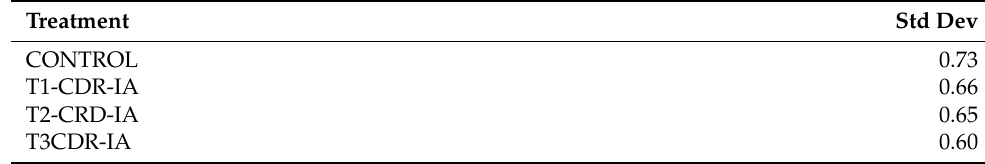
Table A6. Standard deviation per treatment.